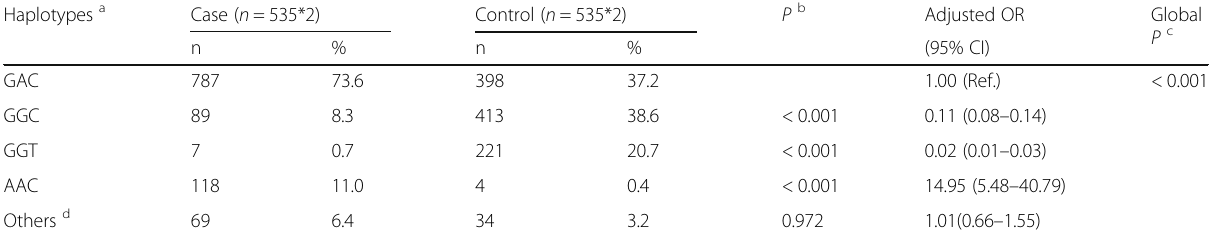
Table 5 Frequencies of inferred haplotypes among the cases and controls and their association with risk of NIHL Haplotypes a